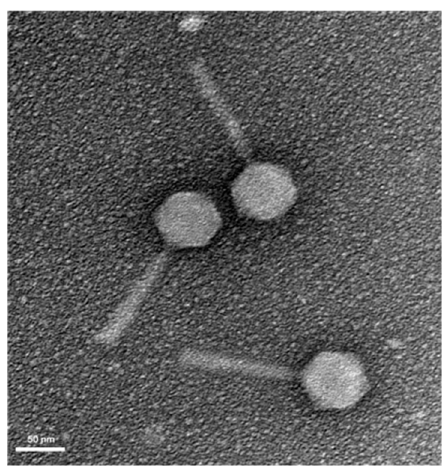
Figure 1. TEM image of P. aeruginosa specific phage EPA1 obtained by negative staining with 2% ( w / v ) uranyl acetate. Scale bar represents 50 nm.